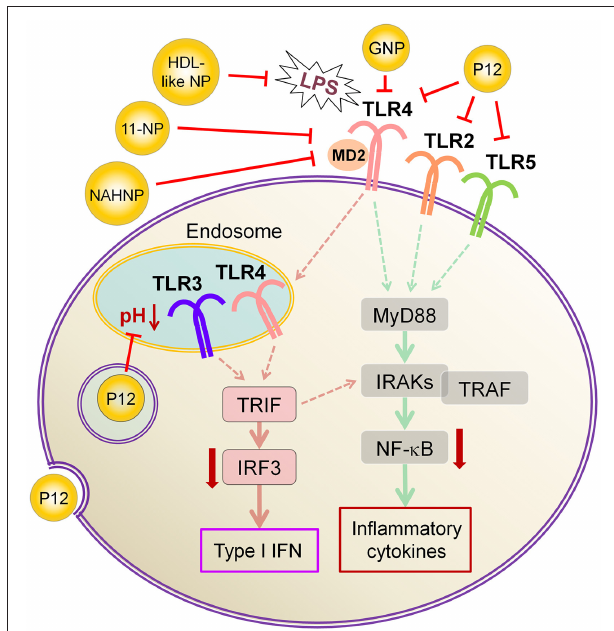
FIGURE 3 | The mechanisms of action of emerging nano-inhibitors targeting TLR signaling pathways. The HDL-like NP is capable of sequestering LPS to down-regulate TLR4 signaling; NAHNP and 11-NP can block the LPS binding to TLR4-MD2 complex, and thus inhibit TLR4 signal transduction; bare gold nanoparticle (GNP) is able to down-regulate TLR4 expression; the peptide-gold nanoparticle hybrid P12 can inhibit multiple TLR pathways including TLR2, 3, 4 and 5, and block the endosomal acidification. These nano-inhibitors can eventually down-regulate the transcription factors NF- κ B and IRF activation, leading to the inhibition of the production of inflammatory cytokines and type I